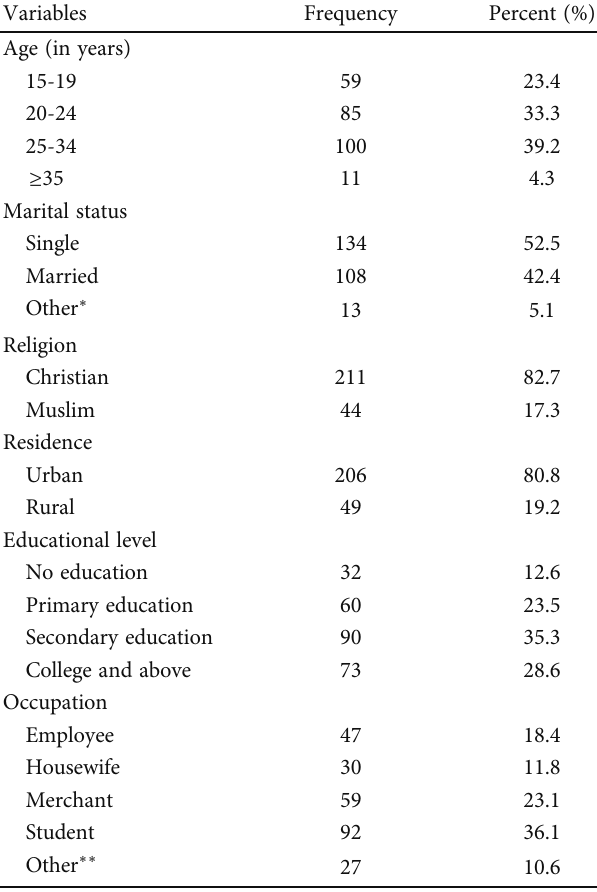
Table 2: Distribution of participants receiving abortion care by their previous reproductive health experience and health facility- related factors in Mojo town.